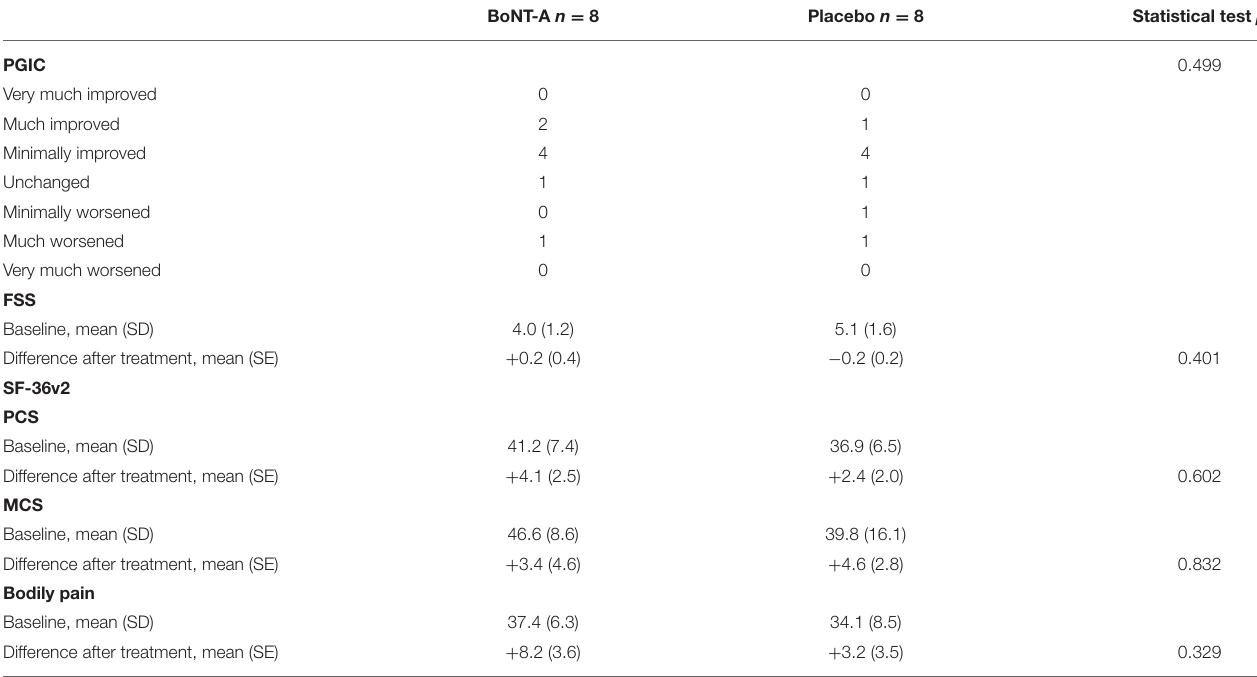
TABLE 4 | Exploratory analyses of patients’ global impression of change, fatigue severity, and self-reported physical and mental health at 6 weeks after treatment. BoNT-A n = 8 Placebo n = 8 Statistical test p PGIC